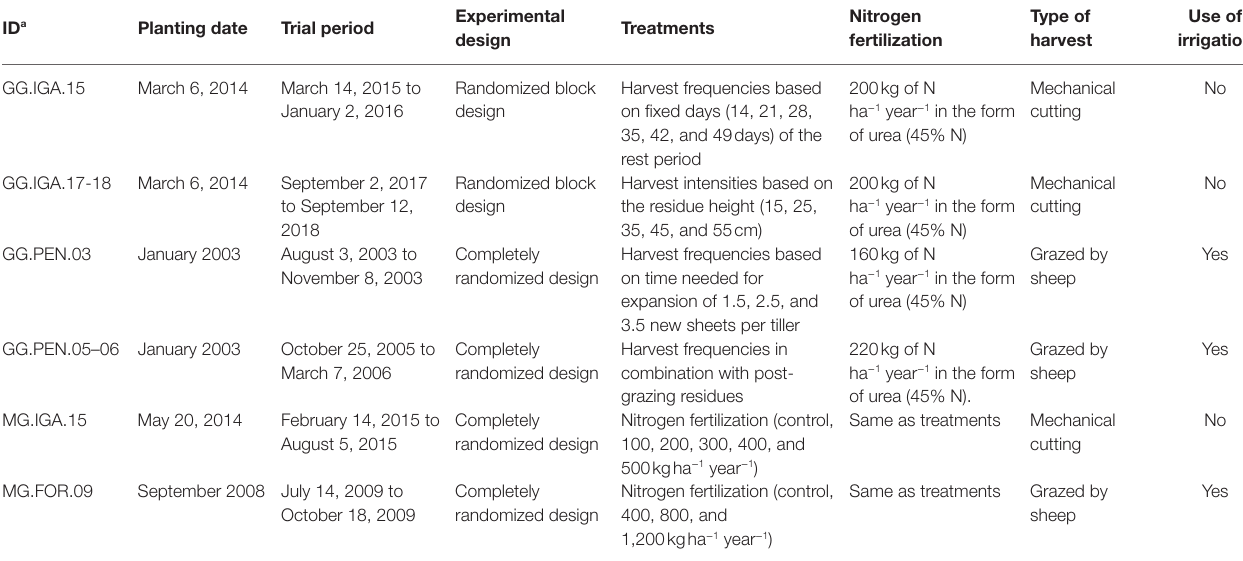
TABLE 2 | Characterization of the experimental and management conditions of each experimental